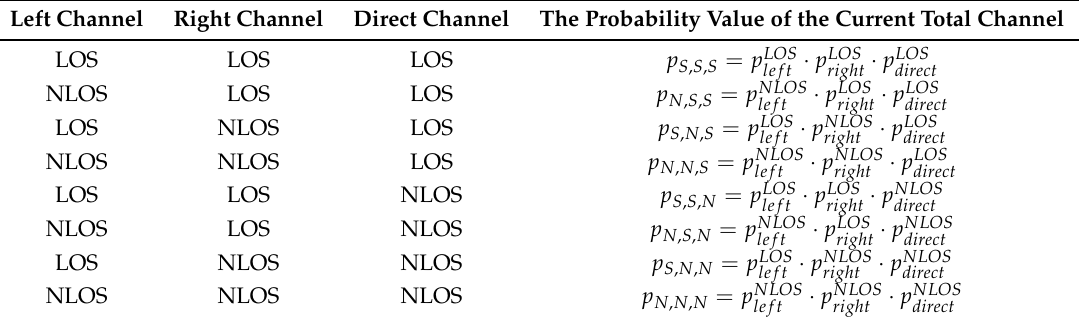
Table 1. Eight different combinations of the overall conditions of the